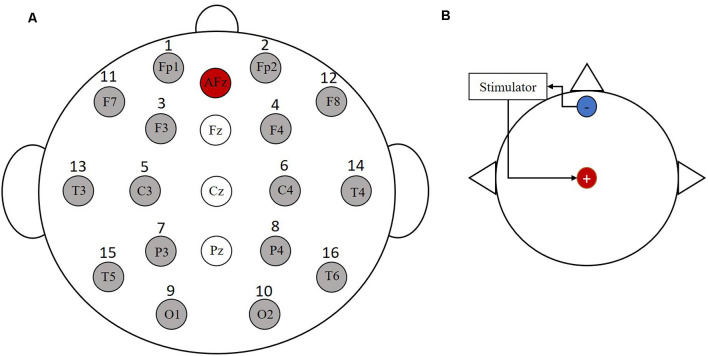
Electrode distribution and stimulation electrode location map. (A) The 16 Ag/AgCl electrodes were employed for data recording. (B) The anode is placed at the Cz and the cathode is placed at the forehead area.